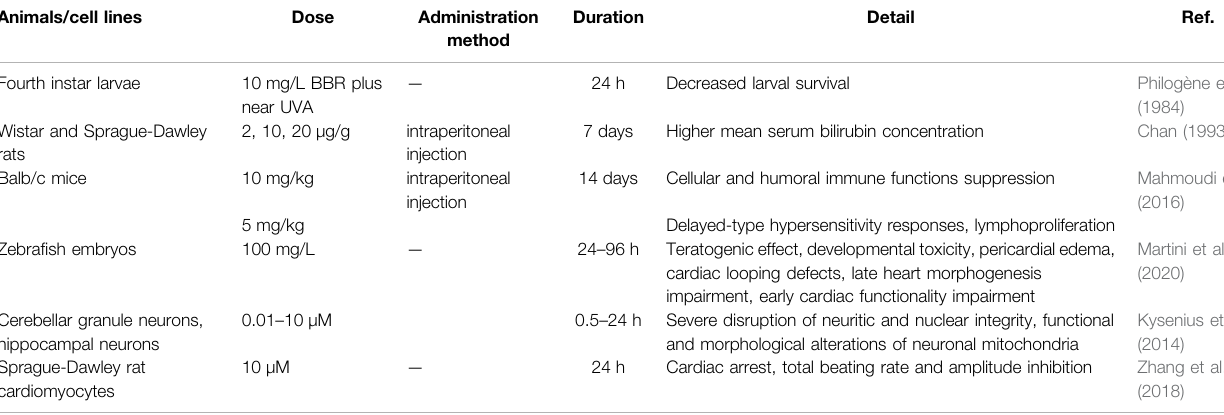
TABLE 2 | Toxicity researches of